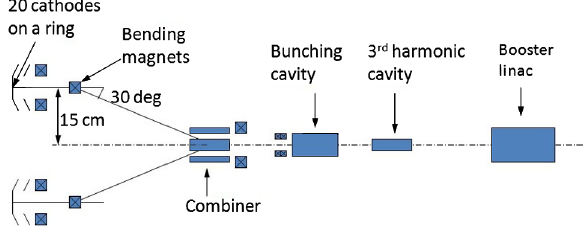
FIG. 1. Schematic layout: ‘‘Multiple-cathode gun’’